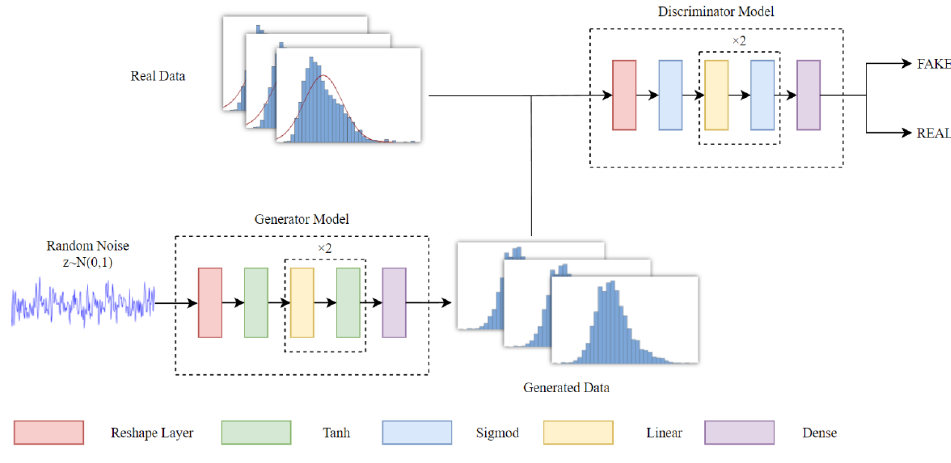
Figure 4. The structure of the